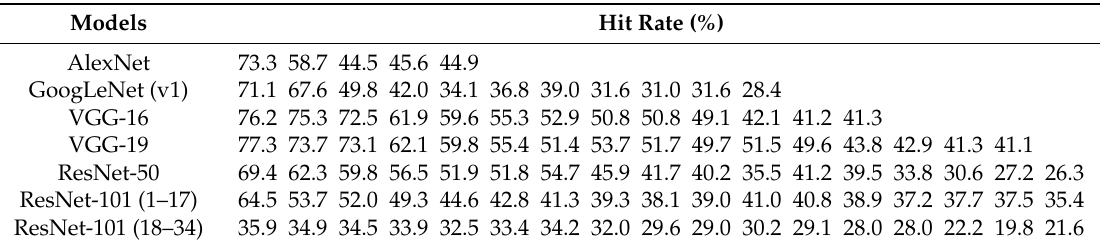
Table 2. Hit rate when applying distance threshold.